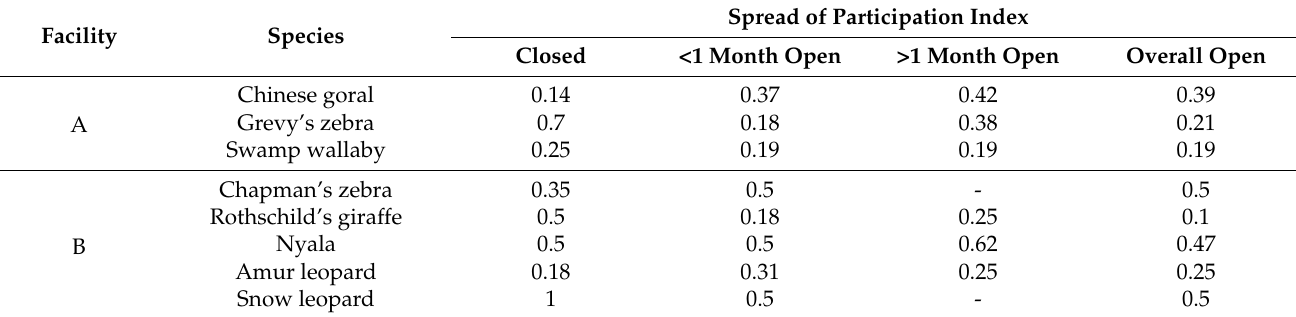
Table 4. SPI values during open and closed periods for all of the study species. A value of 0 suggests equal use of all zones, whereas a value of 1 suggests exclusive use of one